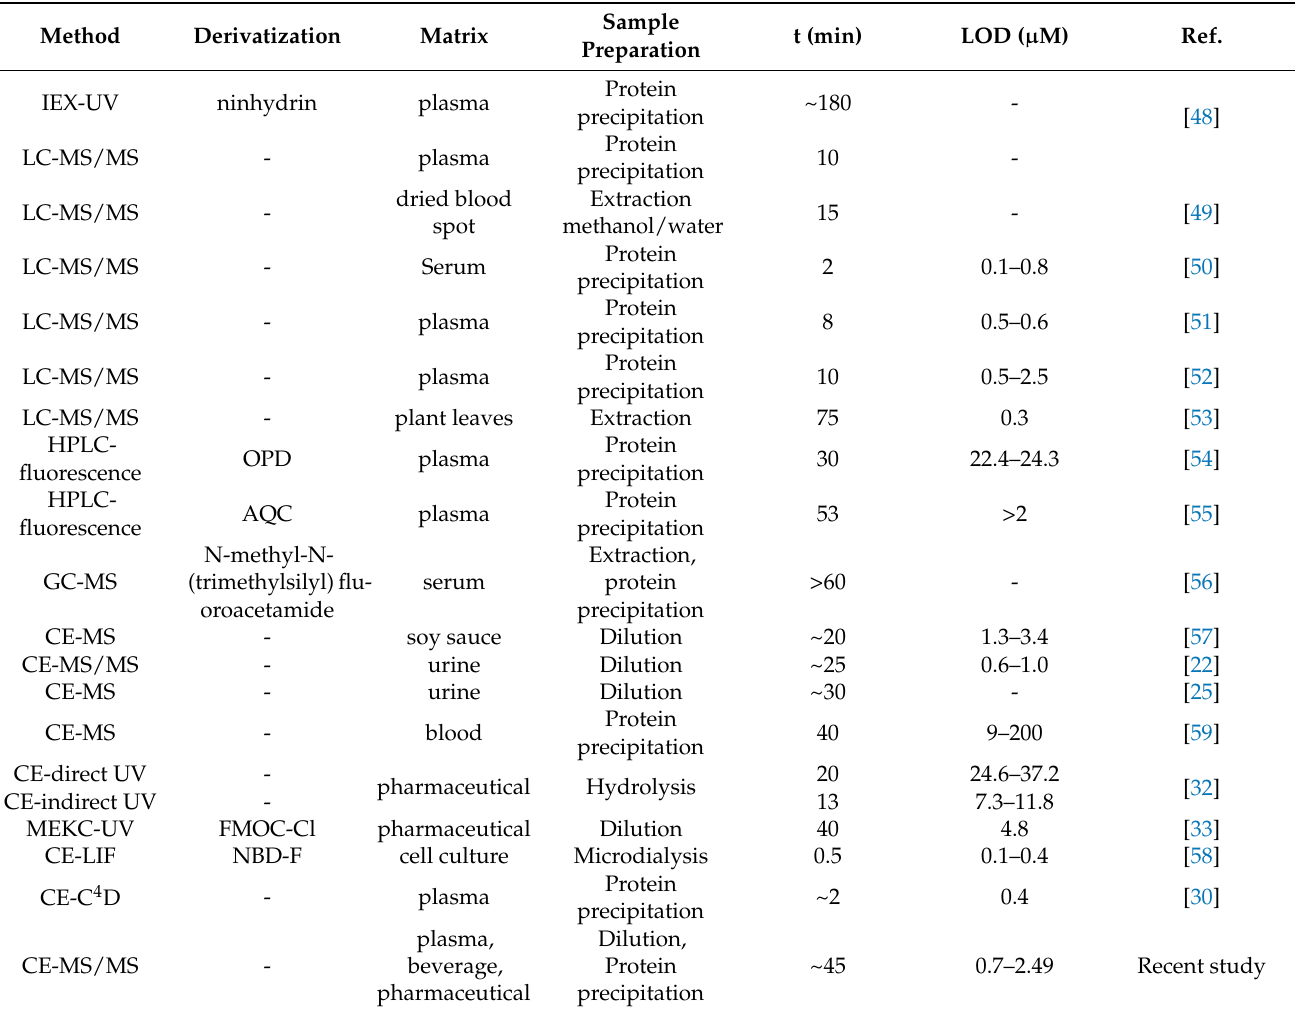
Table 12. Overview of the chromatographic and electrophoretic methods used for determination of BCAAs in various sample